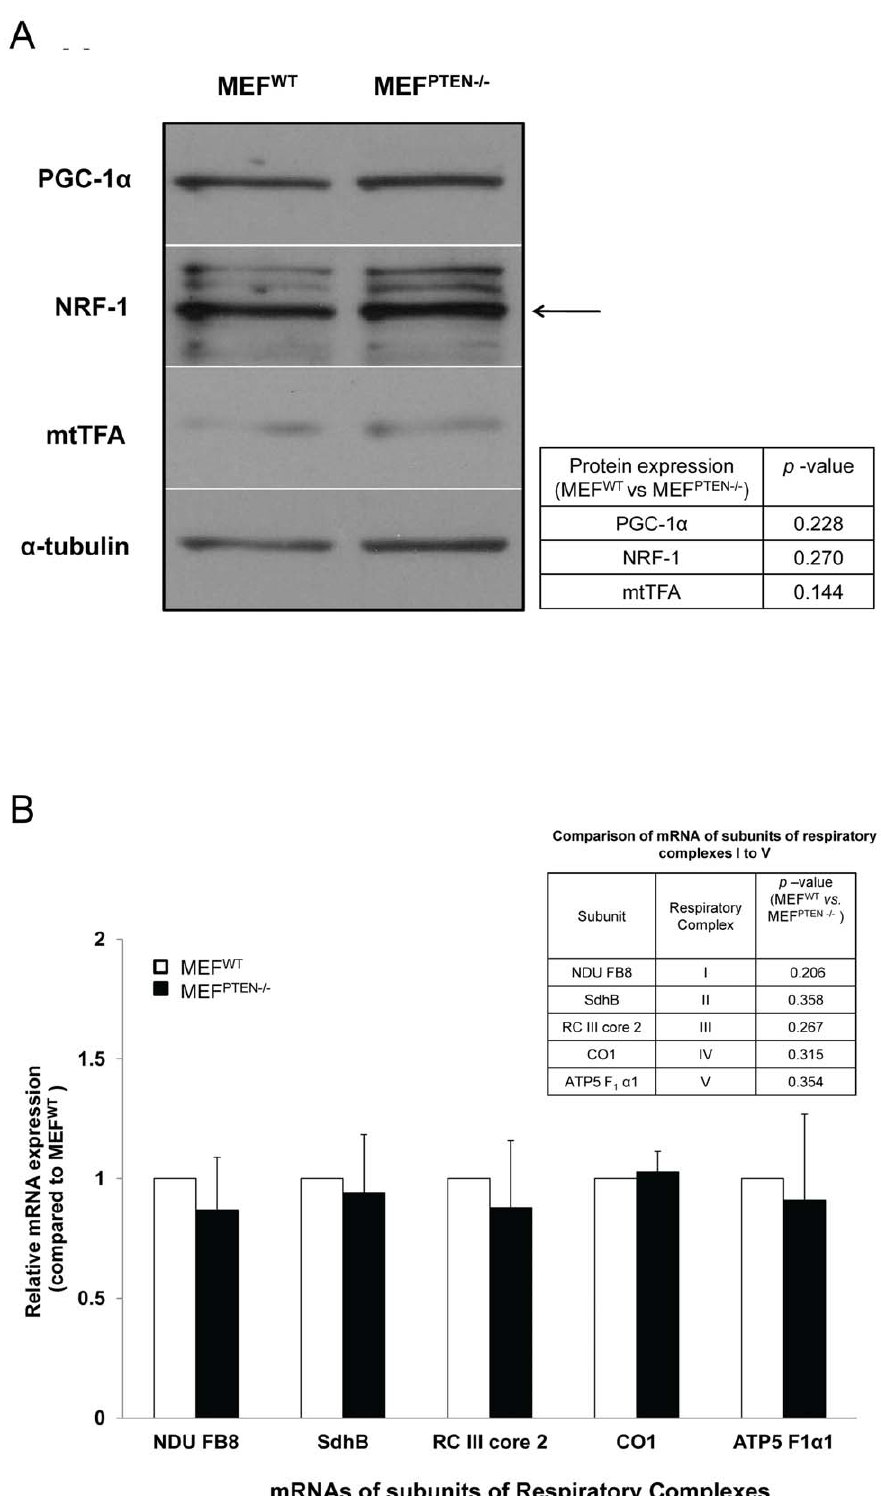
Figure 5. Transcriptional Regulation. ( A ) Western blots of mitochondrial transcription factors The protein expressions of peroxisome proliferator- activated receptor gamma coactivator 1-alpha (PGC-1 a ), nuclear respiratory factor-1 (NRF-1) and mitochondrial DNA transcription factor A (mtTFA) were measured in MEF WT and MEF PTEN 2 / 2 . Quantitative analysis showed no significant difference between the two (inset). ( B ) Measurement of mRNA by real-time PCR The mRNAs of the five subunits RCs used in our Western blot analysis were not significantly different in MEF PTEN 2 / 2 and MEF WT with p values shown in the accompanying table (inset). Mouse alpha 1A tubulin was used for normalization.